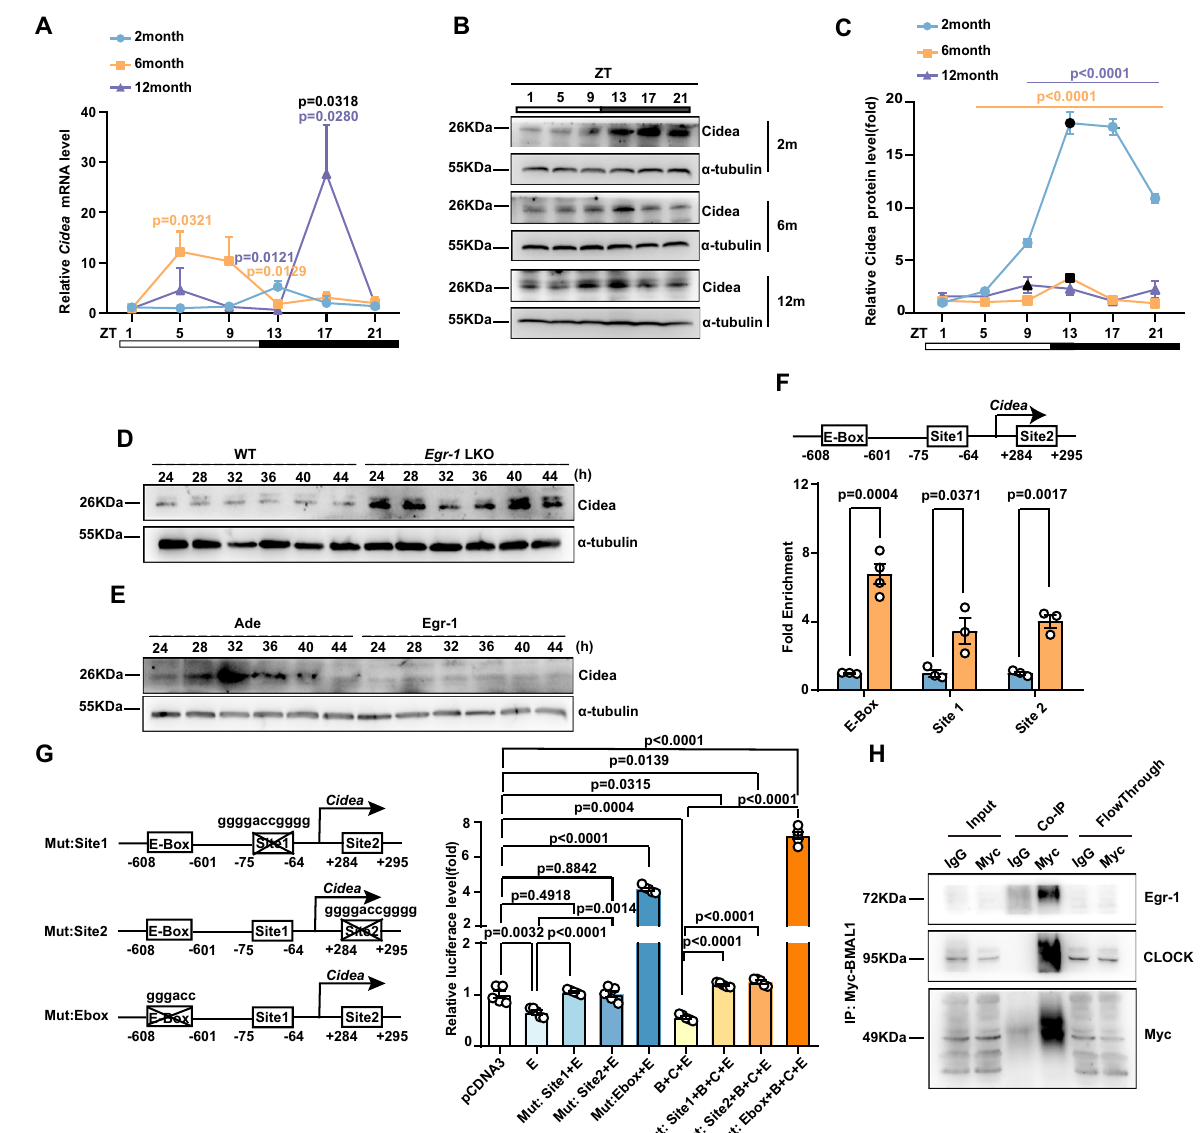
Fig. 6 | Egr-1/BMAL1/CLOCK regulates the robustness and rhythm of Cidea by inhibiting its transcription. A mRNA expression of Cidea at the indicated time points in livers from C57BL/6J mice at 2 months, 6 months, and 12 months of age (2 months ZT1: n =6, ZT5: n =5, ZT9,13,17,21: n =4; 6 months ZT1: n =4, ZT5,13: n =6,ZT9: n =5,ZT17,21: n =4;12months: n =4biologicallyindependentanimals); B Protein levels of Cidea at the indicated time points in livers from B6 mice at 2months,6months,and12monthsofagethatwereentrainedtoa12-hlight/dark cycle. C Quantitative analysis of Cidea protein levels in Fig. 6B ( n =4 biologically independentanimalspergroup). D ProteinlevelsofCideainprimaryhepatocytes isolated from 6-month-old C57BL/6J mice after deletion of Egr-1. E Protein levels of Cidea in primary hepatocytes isolated from 6-month-old C57BL/6J mice